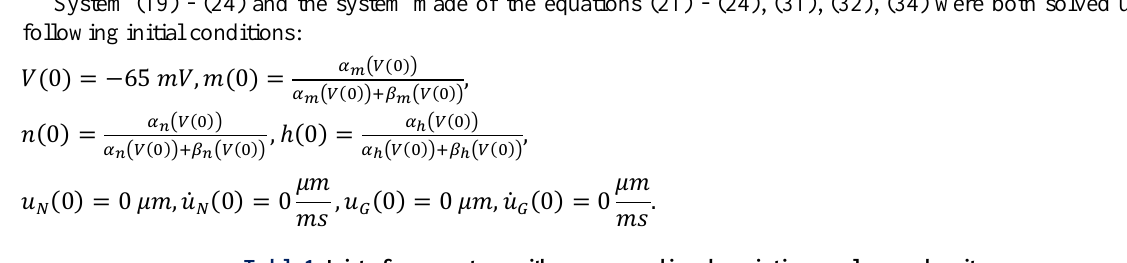
Table 1. List of parameters with corresponding descriptions, values and